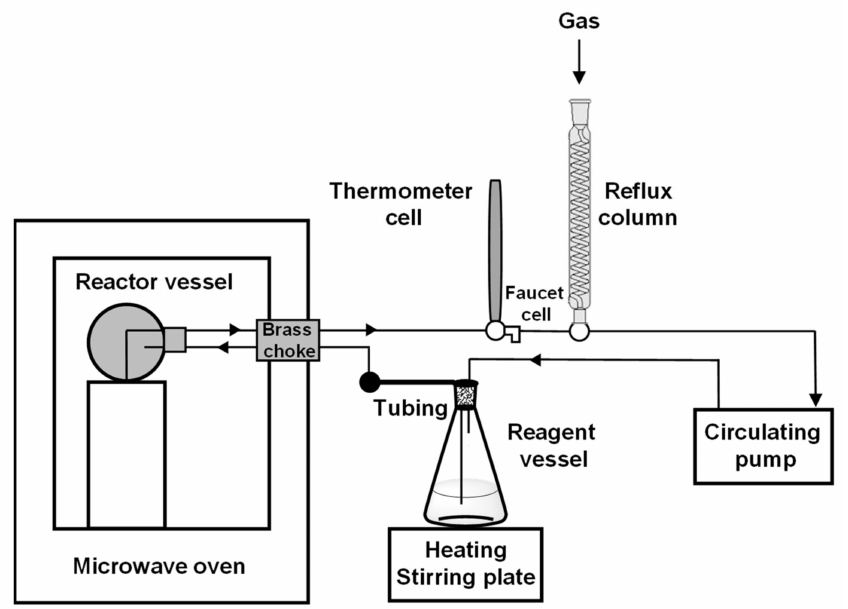
Figure 18. Con-Flow microwave